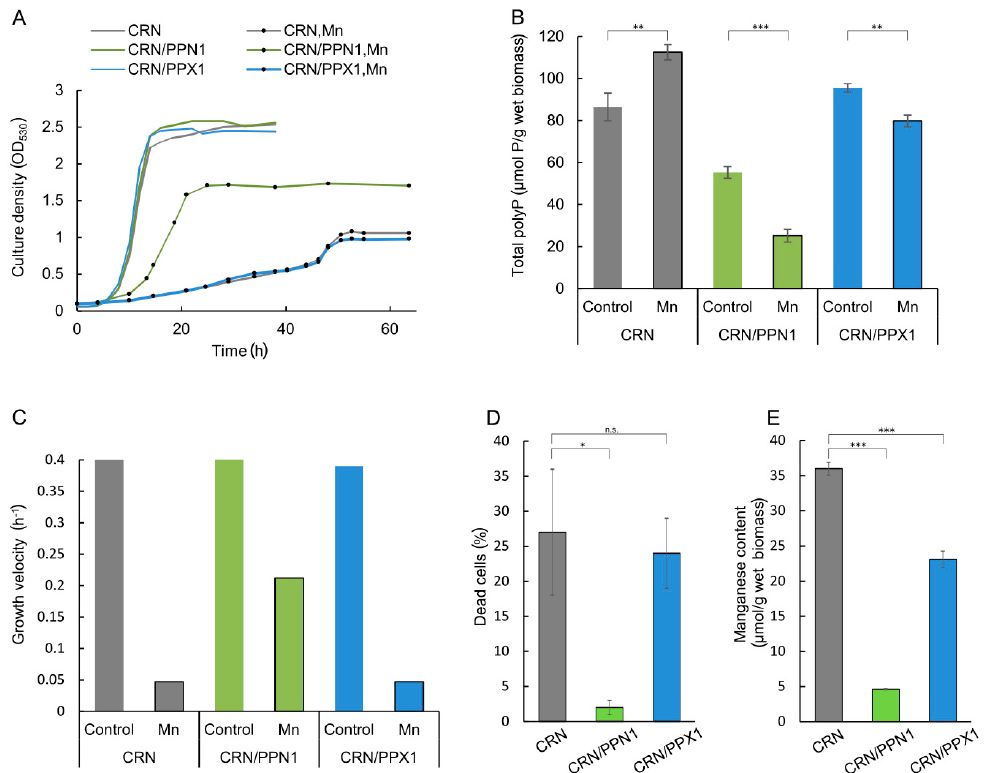
Figure 1. Growth characteristics and polyphosphate content in the cells of CRN, CRN / PPN1, and CRN / PPX1 strains of S. cerevisiae cultivated in control YPD medium with 14 mM KH 2 PO 4 and in the same medium supplemented with 5 mM MnSO 4 . ( A ) growth curves; control medium—lines without dots; manganese excess medium—lines with dots; CRN is shown in gray, CRN / PPN1 in green, and CRN / PPX1 in blue; ( B ) growth velocities, logarithmic growth stage; ( C ) manganese content in the cells grown in the presence of 5 mM MnSO 4 , logarithmic growth stage: CRN (40 h growth), CRN / PPN1 (16 h growth), and CRN / PPX1 (40 h growth); ( D ) the percentage of dead cells in the logarithmic growth stage in the presence of 5 mM MnSO 4 ; ( E ) total polyphosphate content in control and manganese grown cells, stationary growth stage. Three replicates were performed for each experiment; mean ± s.d. is shown on panels ( B , D , E ). Two-sample t-test was used to assess the statistical significance: *** p -value < 0.001, ** p -value < 0.01, * p -value < 0.05, n.s.—not significant.